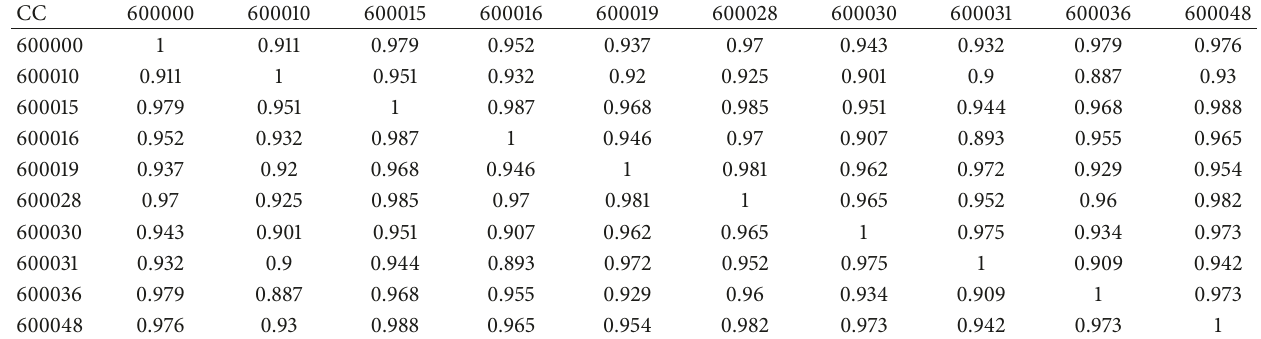
Table 8: True correlation